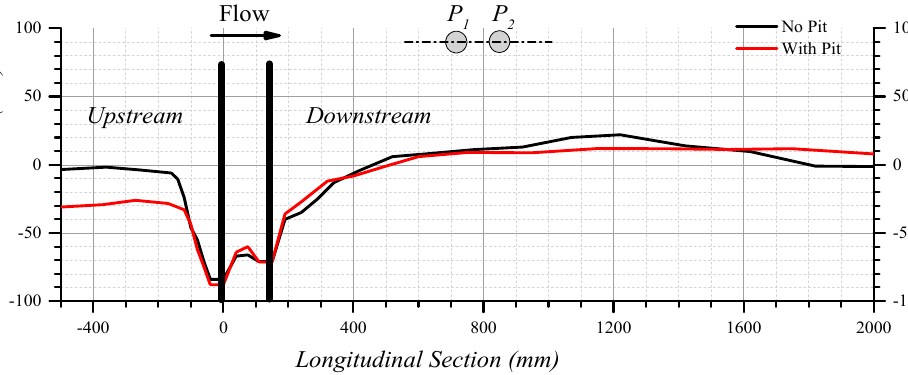
Figure 10. Cross-sections along both the piers and longitudinal section along the centerline.